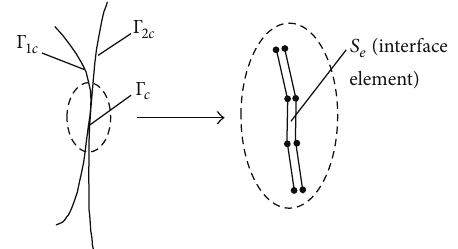
Figure 2: Interface element